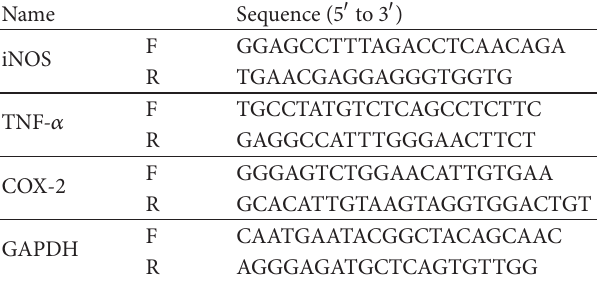
Table 1: Real-time PCR primers used in this